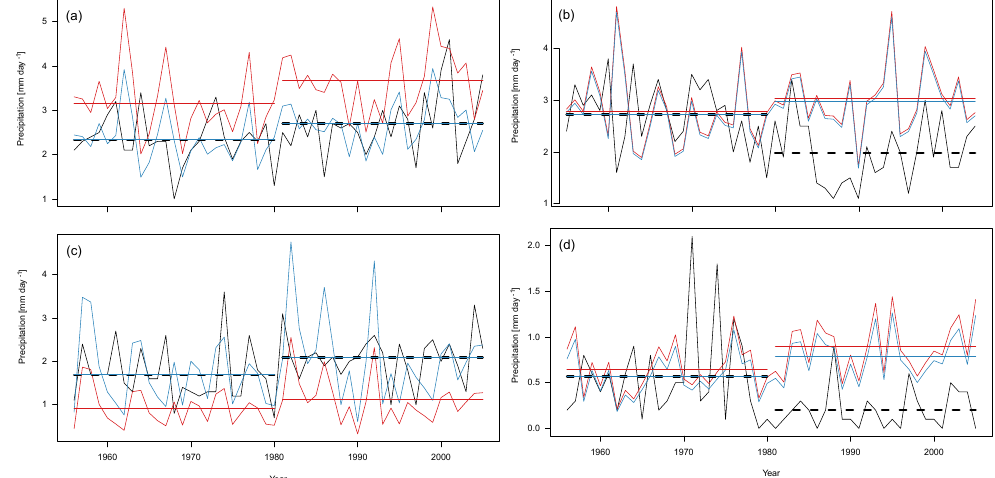
Figure 2. Time series of boreal summer (JJA) precipitation. (a) case 1 (true negative); (a) case 2 (false positive); (c) case 3 (false negative); (d) case 4 (true negative). Black: E-OBS; red: raw EC-EARTH; blue: bias-corrected EC-EARTH. The straight horizontal lines depict the long-term means over calibration and validation periods,